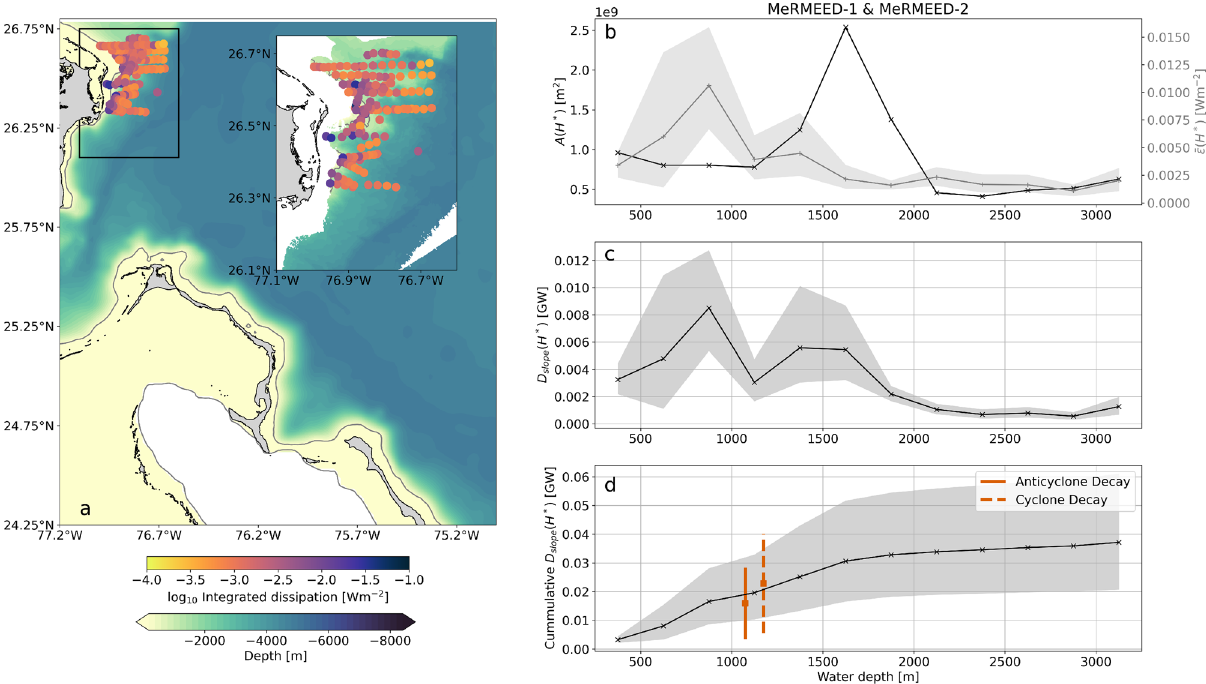
Figure 7. Turbulent dissipation in the MeRMEED study region. ( a ) Integrated turbulent dissipation measured using a tethered vertical microstructure profiler during the MeRMEED fieldwork campaign. Bathymetery from ETOPO-1 is shown in the main panel and swath-based bathymetry is shown in the inset panel that shows the ∗ ) MeRMEED cruise region. The grey contour is the 250 m depth contour. ( b ) Total isobath area ( A ( H ) for bins of water depth based on ETOPO-1 for the entire domain shown in ( a ) and integrated isobath dissipation rate ∗ ) ( ¯ ǫ( H ) averaged in depth bins based on the depth at the location of the profile. ( c ) Turbulent dissipation rate ∗ ) ∗ ) ∗ ) ∗ ) ( D slope ( H ) from the product of A ( H and ¯ ǫ( H . ( d ) D slope ( H accumulated in depth space shown with the eddy kinetic energy decay rate for anticyclones (orange solid line) cyclones (orange dashed line) between 10 and 60 days before eddy decay from Fig. 6c. The shading represents an estimate of the uncertainty in the mean isobath integrated dissipation rate calculated using Monte-Carlo based bootstrapping. The map in panel ( a ) was created using the Python packages cartopy v0.18 and matplotlib v3.3.4, with ETOPO1 bathymetry and GSHHG coastline